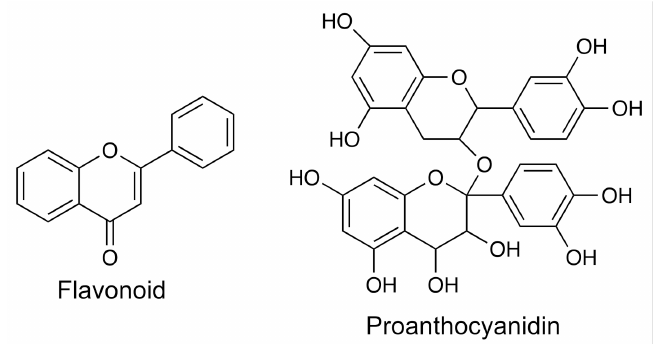
Figure 2. The general structures for flavonoids and